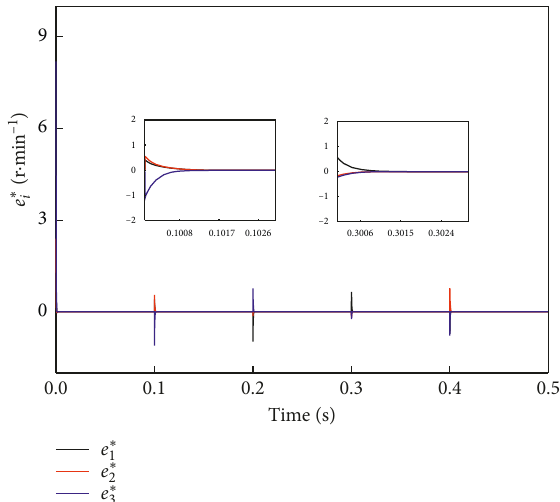
Figure 15: The velocity tracking error curves of all servos under multiple cycles.